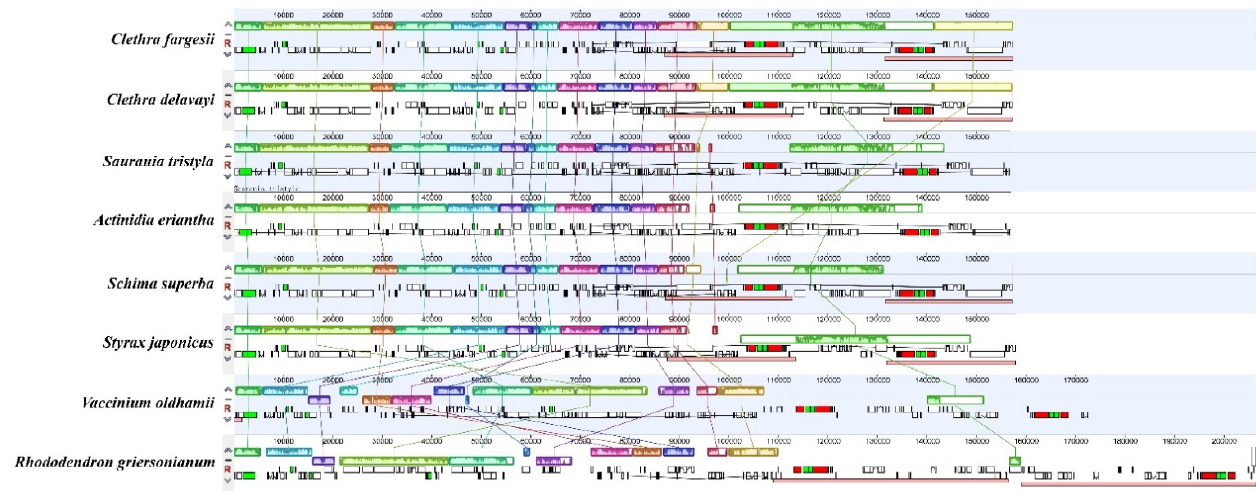
Figure 2. Comparison of the chloroplast genome structures among eight species. Within the alignments, local collinear blocks are represented as blocks of similar color connected with lines. The DNA fragments above the line are corresponding to the clockwise direction and those below the line are counterclockwise direction.